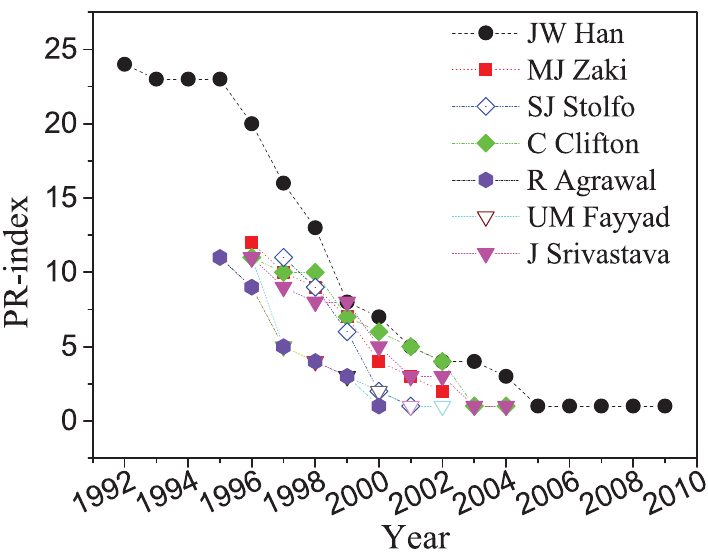
Fig 4. Illustration of evolution mechanism of PR-index sequence. The top of 7 authors are selected based on the ranking of PR-index in Table 2. The PR-index presents different types of decreasing patterns based on the both citations and